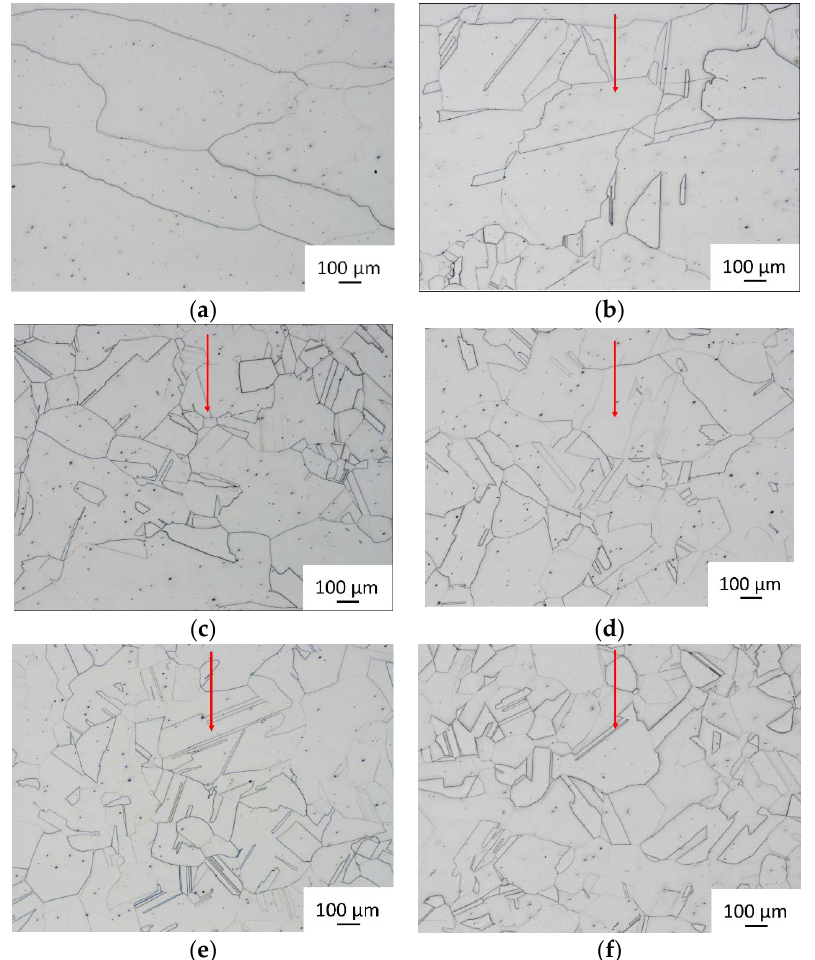
Figure 10. Recrystallization of the MoNiCr alloy: ( a ) initial as-annealed condition; ( b ) 5%; ( c ) 10%; ( d ) 15%; ( e ) 20%; ( f ) 25%. Red arrows indicate the direction of the deformation.